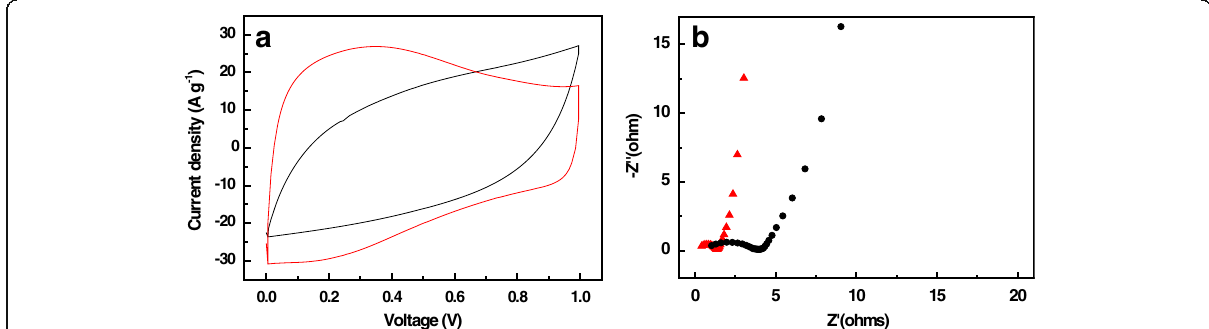
Fig. 5 CV measurements and EIS tests. a CV curves at the scan rate of 200 mV s − 1 and b Nyquist plots of the CGACF ( red line and symbol) and AC samples ( black line and